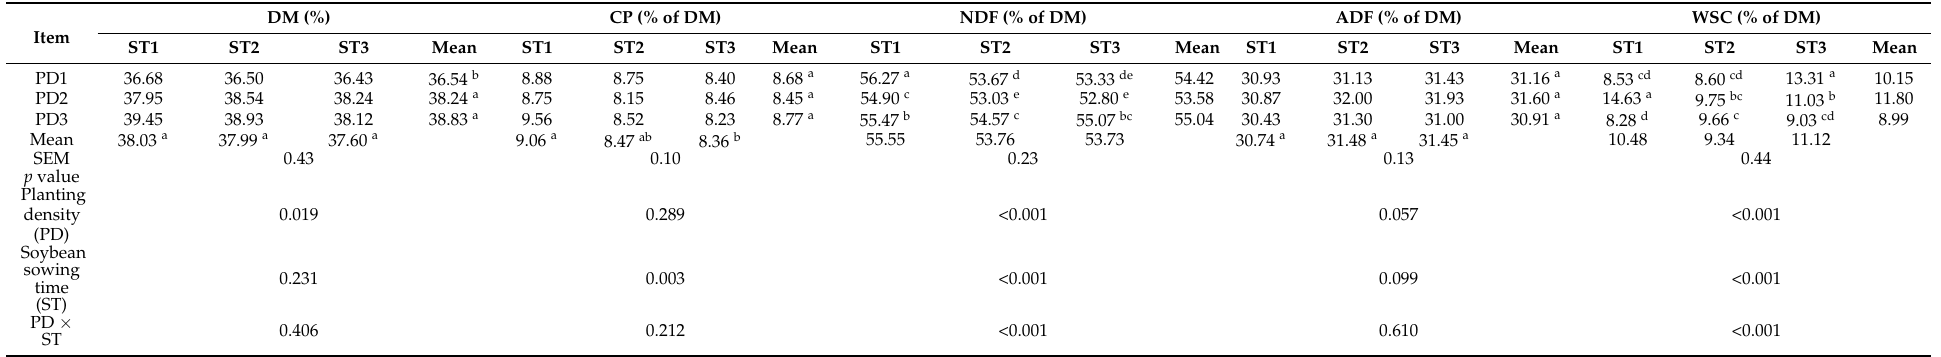
Table 4. Effects of sowing time and planting density of soybean on chemical composition of fresh samples in corn-soybean strip intercropping